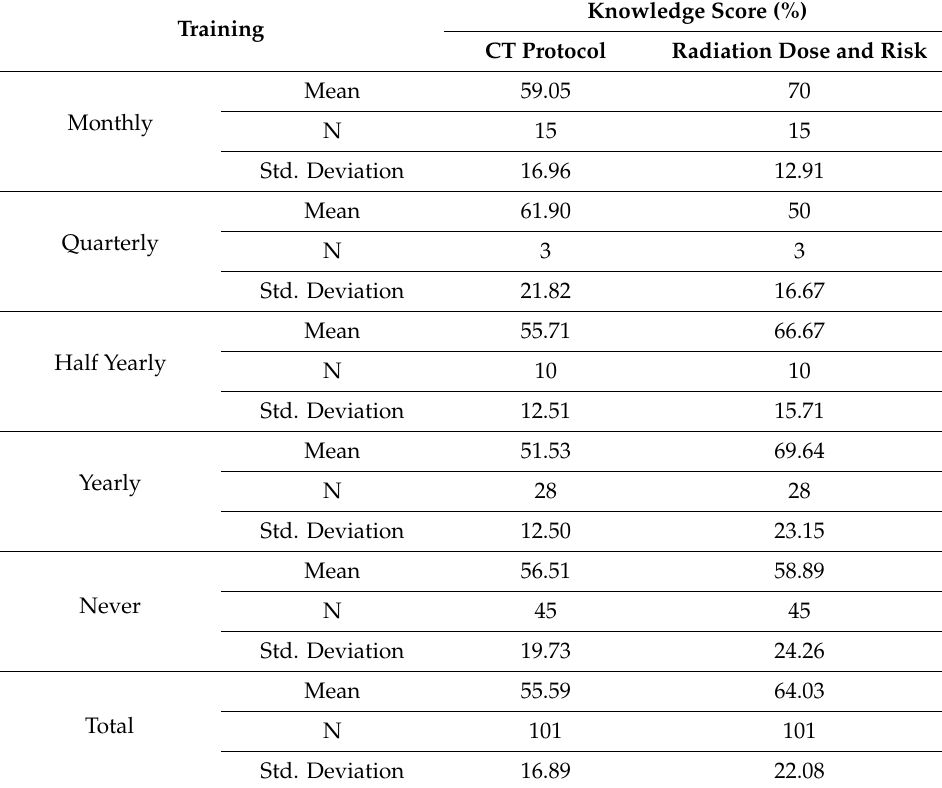
Table 5. Comparison of participants’ knowledge of CT protocol and radiation dose based on training frequency.